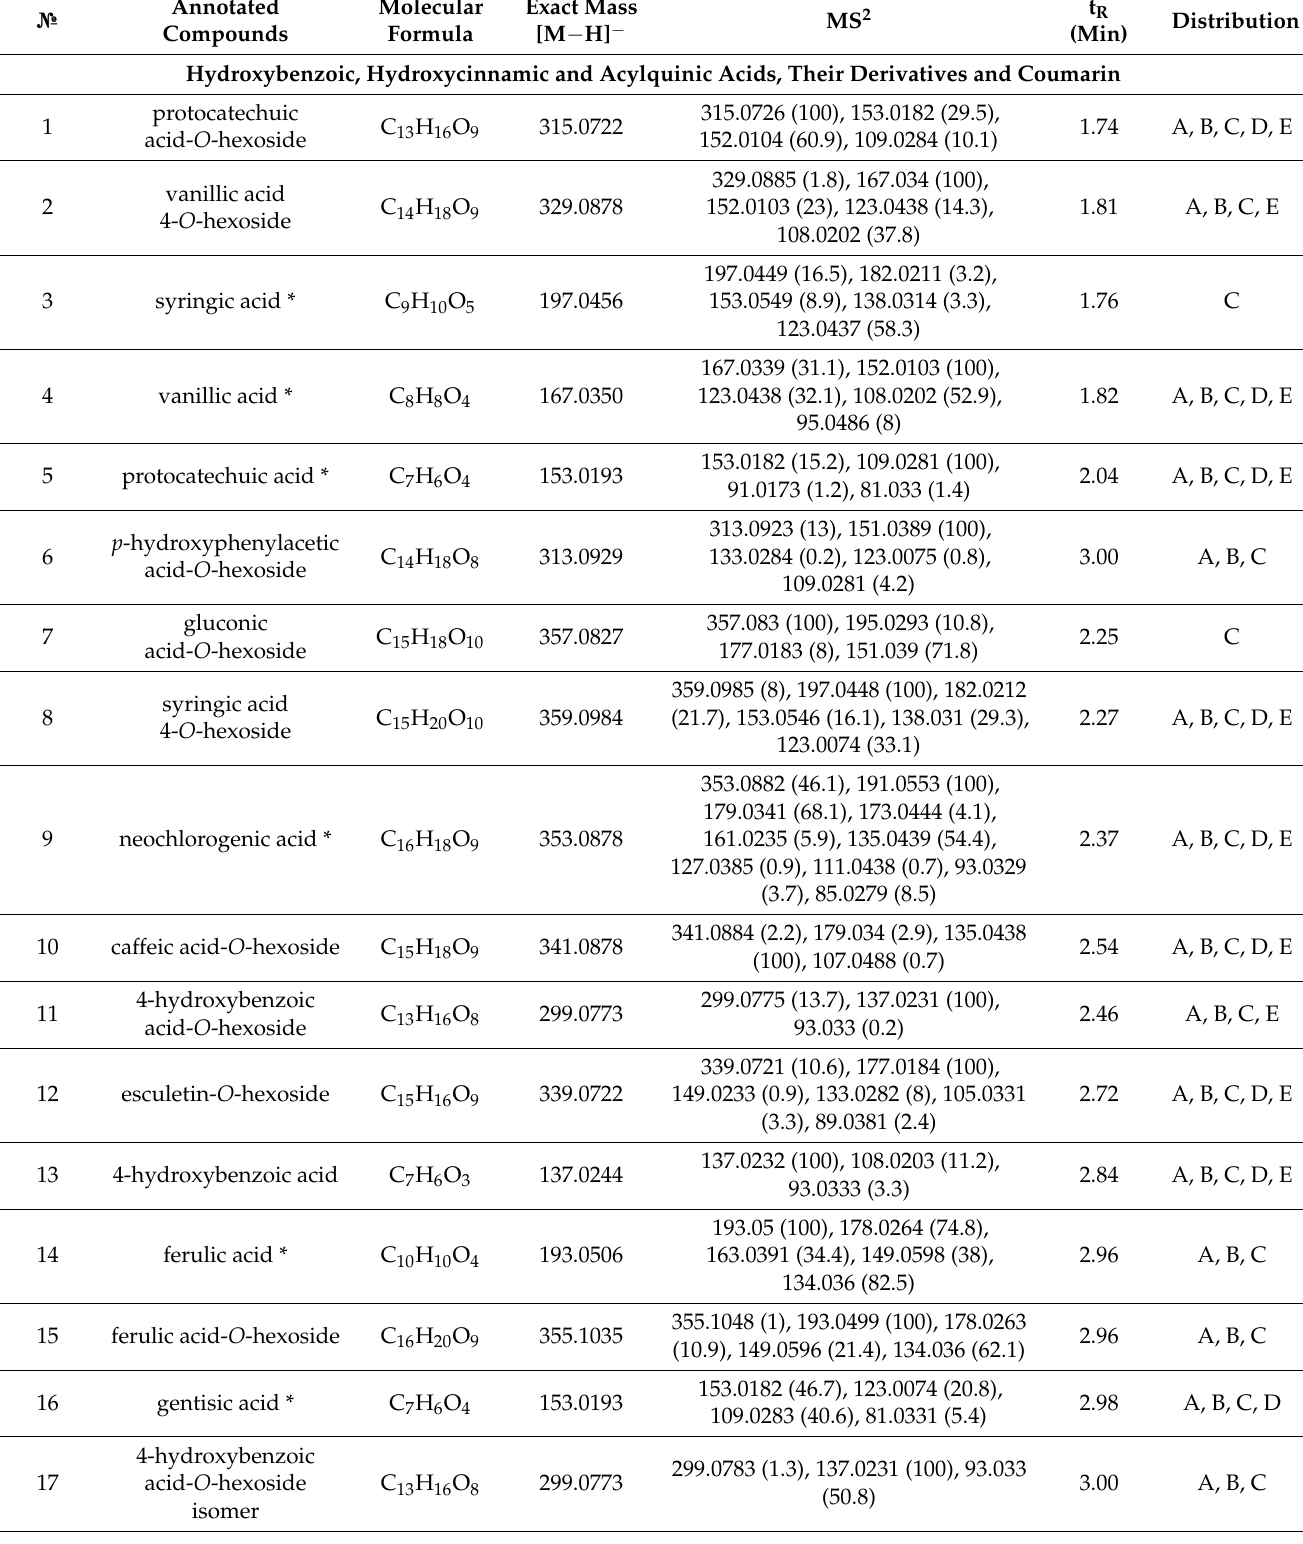
Table 1. Specialized metabolites identified by UHPLC-HRMS. From a total of 68 annotated substances, 24 were identified by a reference standard (marked with